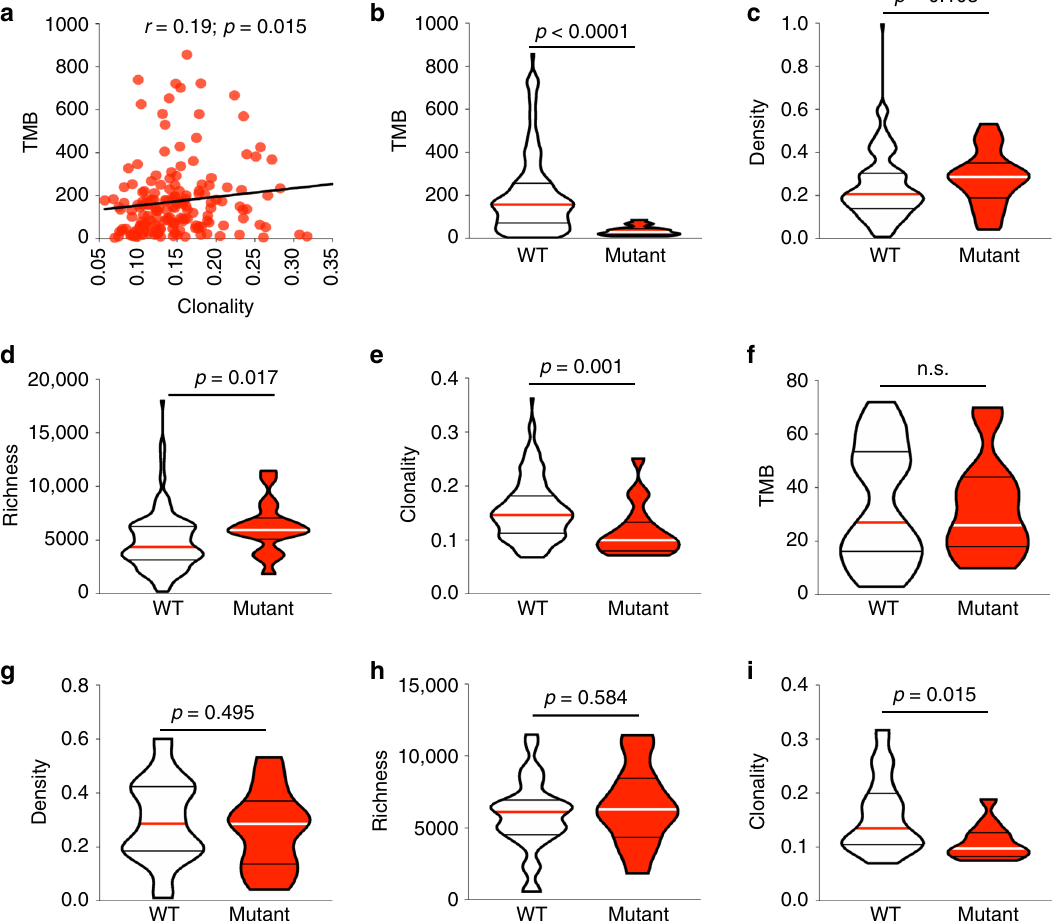
Fig. 3 T cell clonality is lower in EGFR mutant tumors. a Correlation between tumor mutational burden ( n = 215) by whole exome sequencing and clonality. b Tumor mutational burden ( n = 186), ( c ) T cell density ( n = 186), ( d ) richness ( n = 186) and ( e ) clonality ( n = 186) in EGFR wildtype (white) and mutant (red) tumors. f Tumor mutational burden ( n = 51), ( g ) T cell density ( n = 43), ( h ) richness ( n = 43) and ( i ) clonality ( n = 43) in EGFR wildtype (white) and mutant (red) tumors when analyzing only tumors with a low (bottom tertile) TMB. Bars represent median and